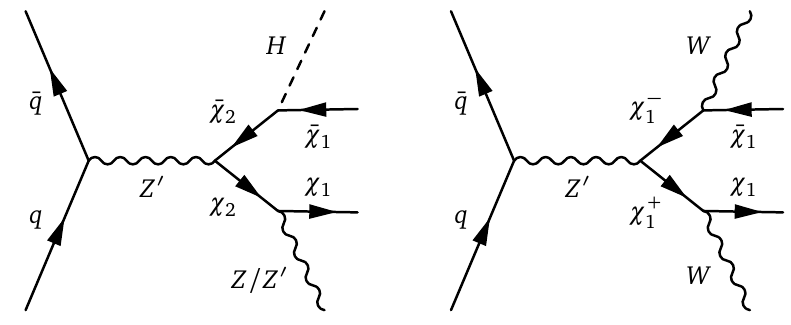
Figure 6: Example pair production processes which contribute to the constraints derived from LHC analyses. Note that the decays of the heavier fermions are three- body if the mass difference to χ heavier fermions for our benchmark points are given in Tables